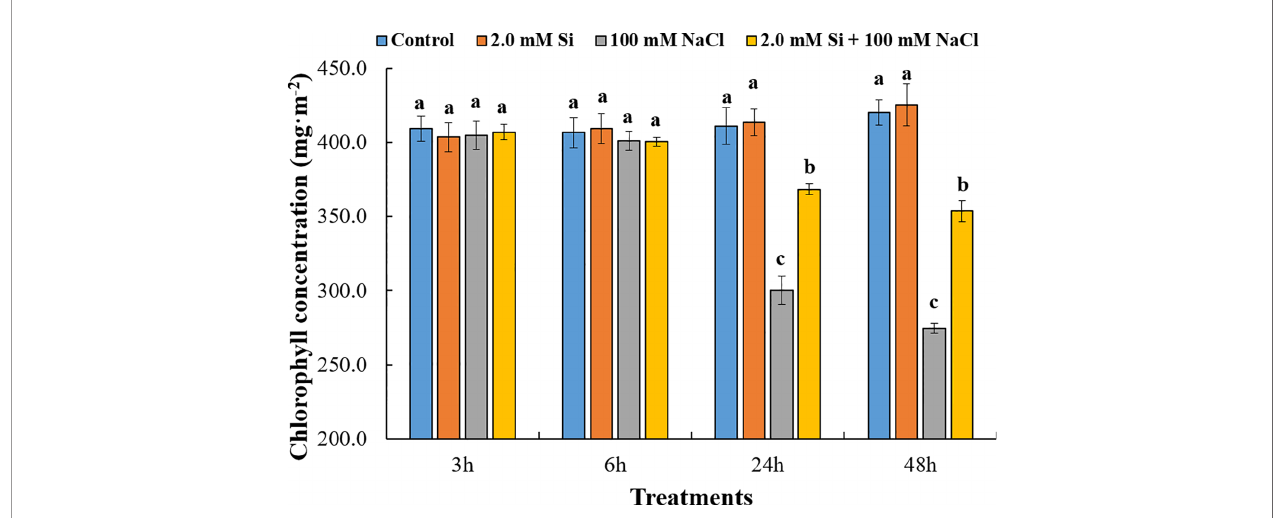
FIGURE 2 | In fl uence of chlorophyll concentration after single or combined Si and NaCl treatments in soybean plants. Data were collected at 3, 6, 24, and 48 h after stress exposure. Different letters above error bars indicate signi fi cant differences by Duncan's multiple range test ( P < 0.05). Data were collected in triplicate and are presented as the average ± standard error ( n = 10).